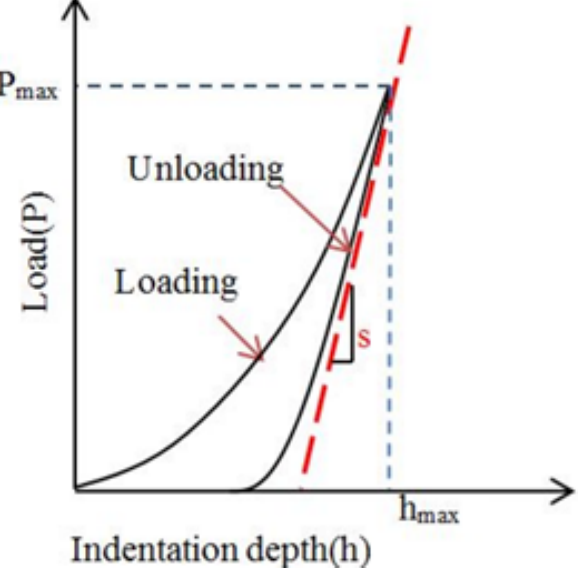
Figure 7. Typical loading-unloading curve of a nano-indentation